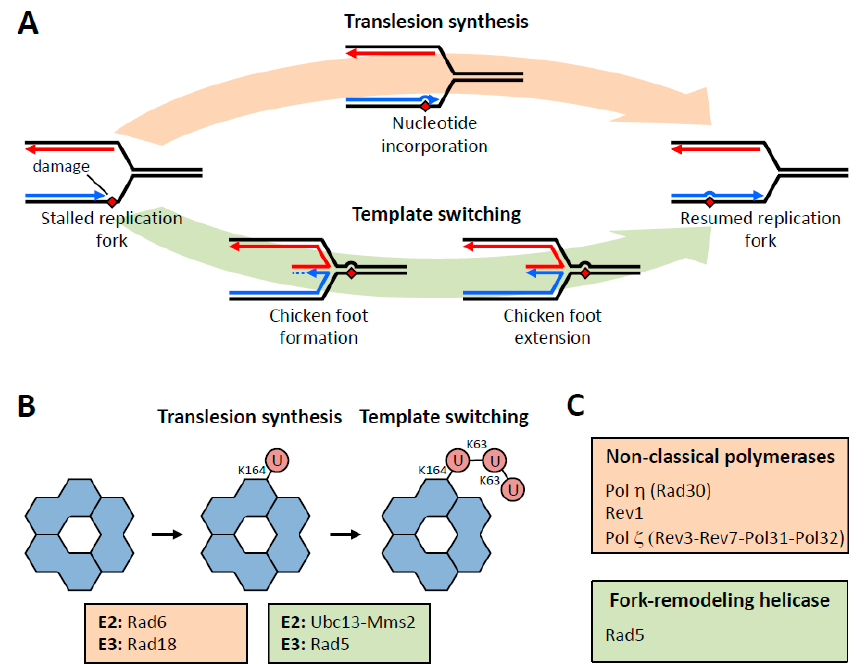
Figure 1. DNA damage bypass pathways and proliferating cell nuclear antigen